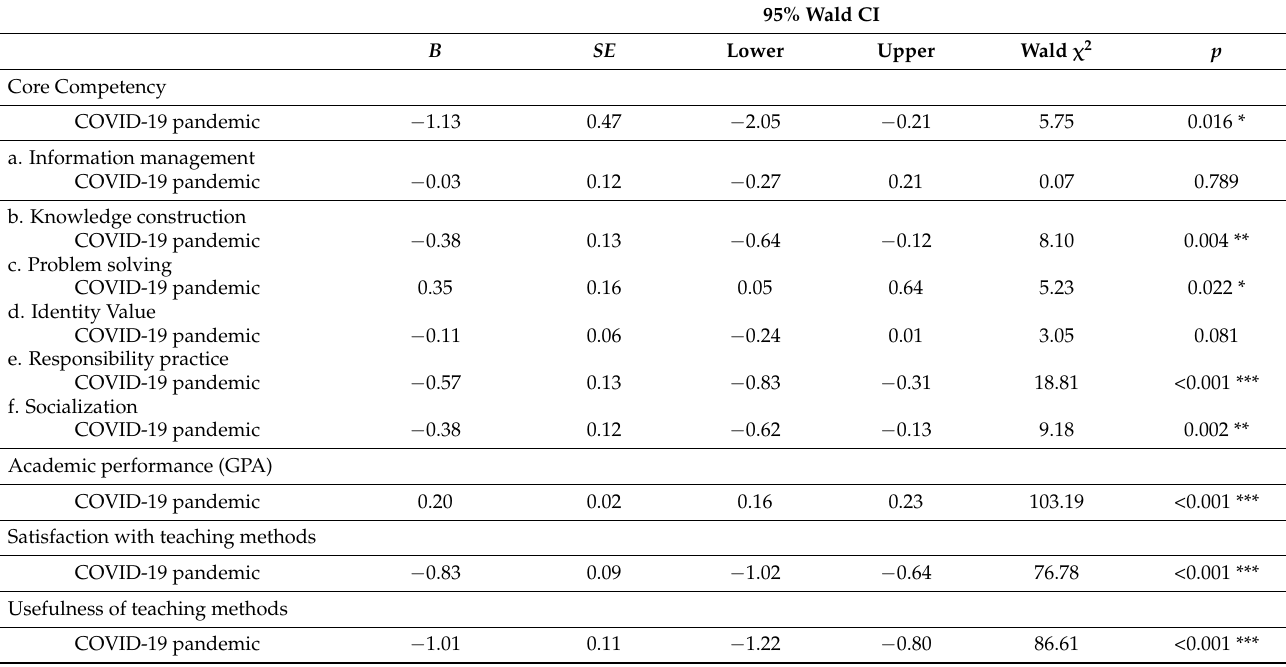
Table 4. Comparison of differences in core competencies, academic performance, satisfaction, and usefulness of teaching methods between before and during the COVID-19